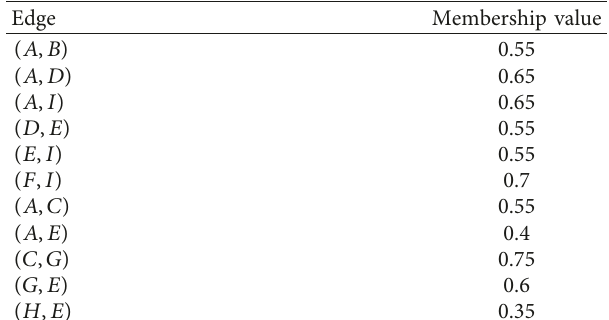
Table 3: Edges membership value of Figure